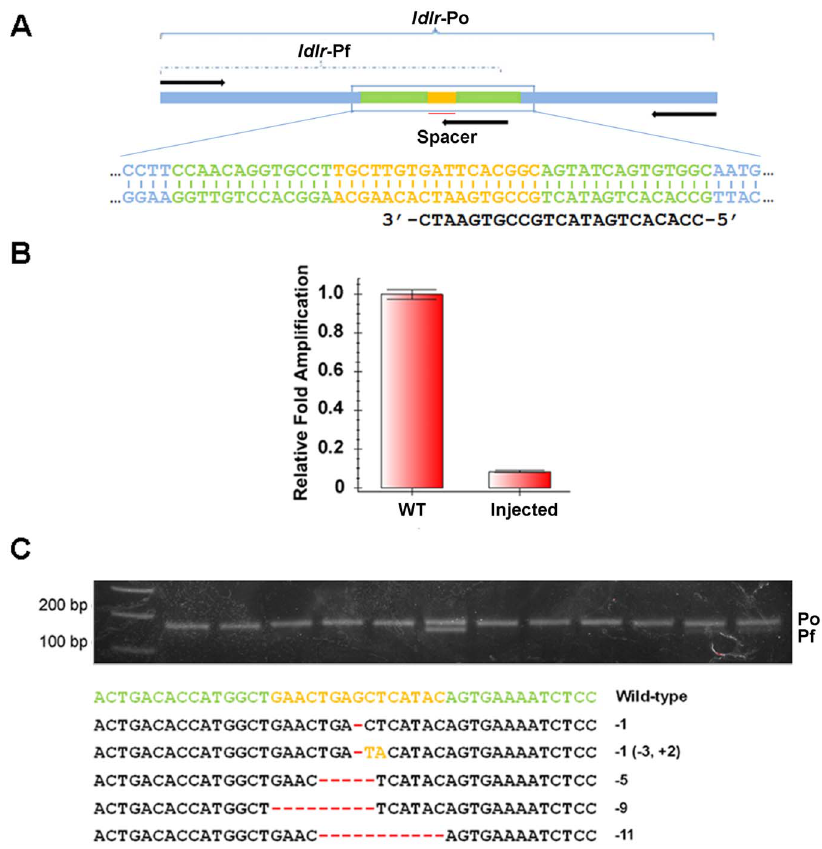
Figure 3. Identification of mutations induced by ldlr TALEN. (A) A schematic diagram showing primers for detecting mutations in TALEN target sites of ldlr gene. (B) The relative amplification efficiency of ldlr Pf primers to Po primers. ldlr TALEN mRNAs injection dramatically reduced the amplification efficiency of ldlr Pf primers. 5 embryos from the wild-type group or the ldlr -TALEN-injected group were pooled and analyzed by qPCR, and 3 pools of each group were analyzed in an independent experiment. Similar results were obtained in three independent experiments. (C) Identification of a mutation in a single allele with T-CIA. Upper panel was an agarose electrophoresis result of PCR products amplified with ldlr Po and Pf primers. Lower panel listed the sequences of mutant colonies identified in upper panel. colonies were analyzed by PCR using primers as described in Table S2. Those colonies that could not generate inside PCR fragments were the putative mutant ones which were further analyzed by DNA sequencing.